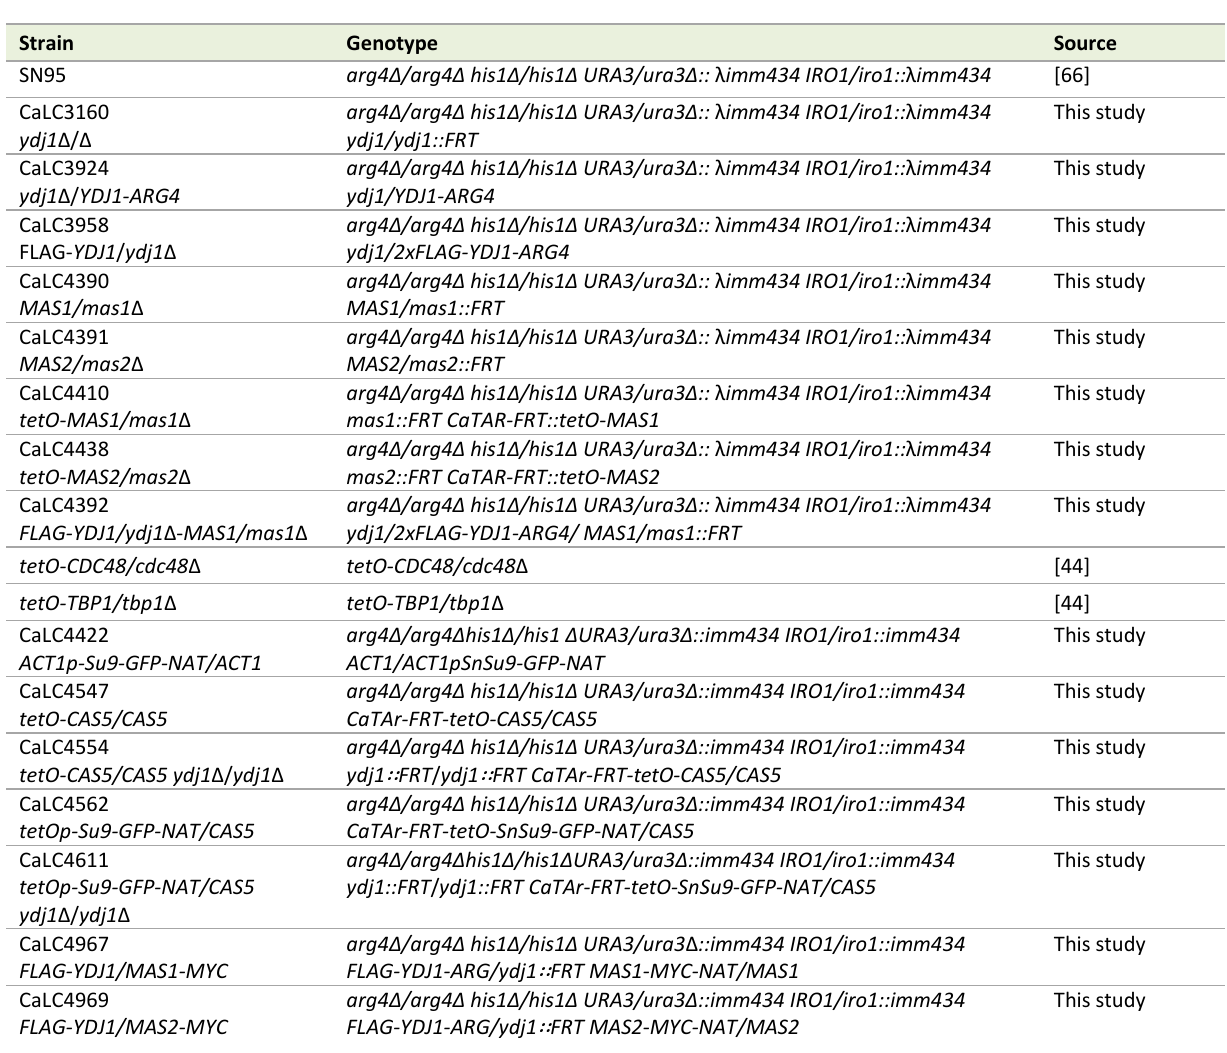
TABLE 1. C. albicans